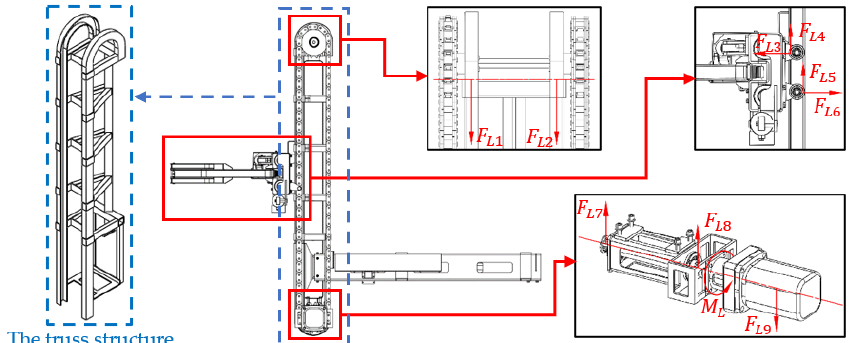
Figure 7. The load on the truss structure.